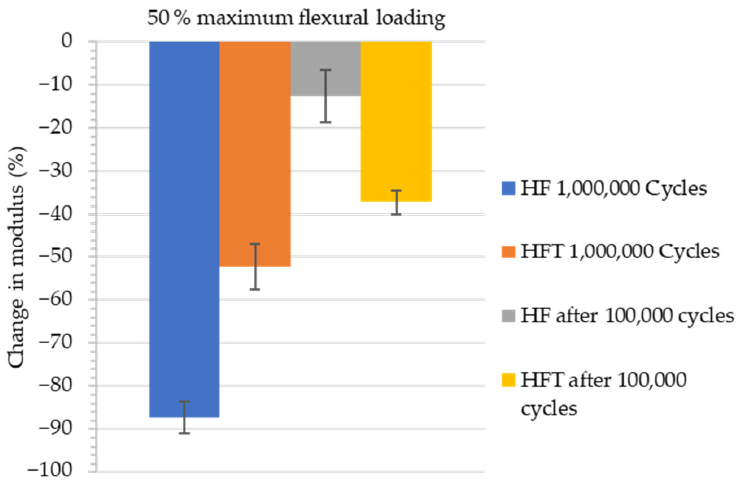
Figure 15. Hybrid fibre at 50% flexural strength cyclic loading. HF and HFT under cyclic 3 point bending for 100,000 and 1,000,000 cycles .